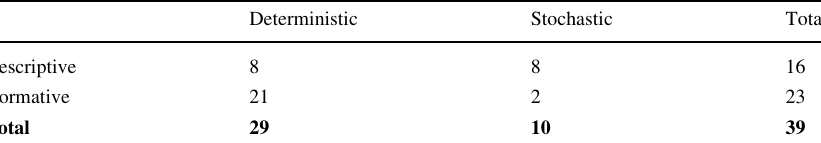
Table 4 Distribution of formal modeling papers regarding the model type